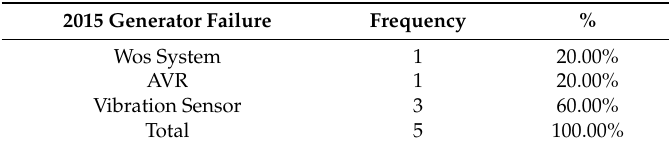
Table 5. Statistical data of failure frequencies, December 2016.